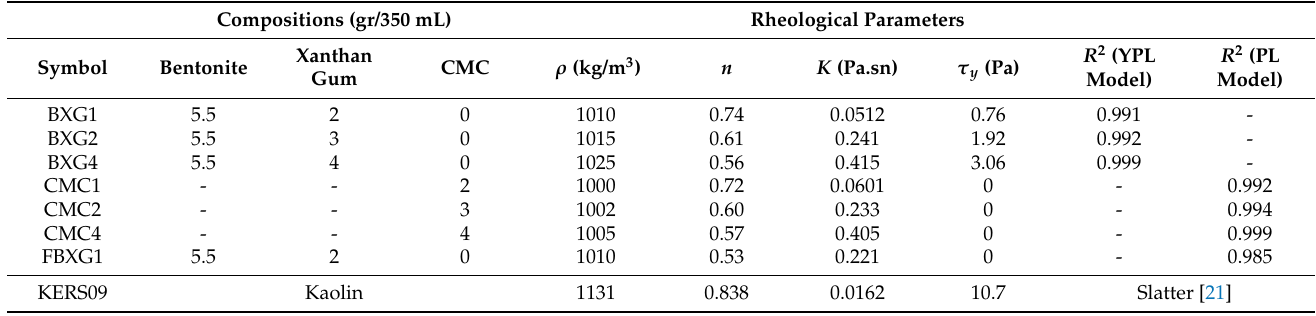
Table 2. The curve-fitted parameters for shear-thinning fluid models are based on the rotational Table 2. The curve- fi tt ed parameters for shear-thinning fl uid models are based on the rotational viscometer (Model 800), and KERS09 fluid came from experimental work provided by Slatter [21]. viscometer (Model 800), and KERS09 fl uid came from experimental work provided by Sla tt er [21]. Rheological Parameters Compositions (gr/350mL) Rheological Parameters